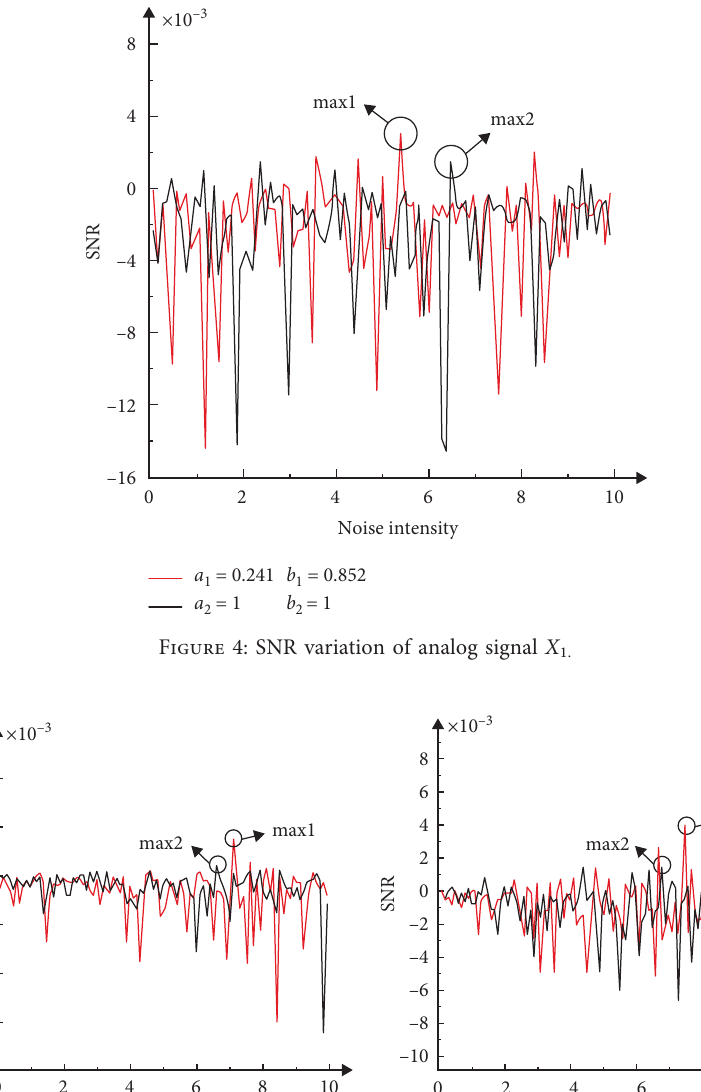
2 and (b) analog signal X 3